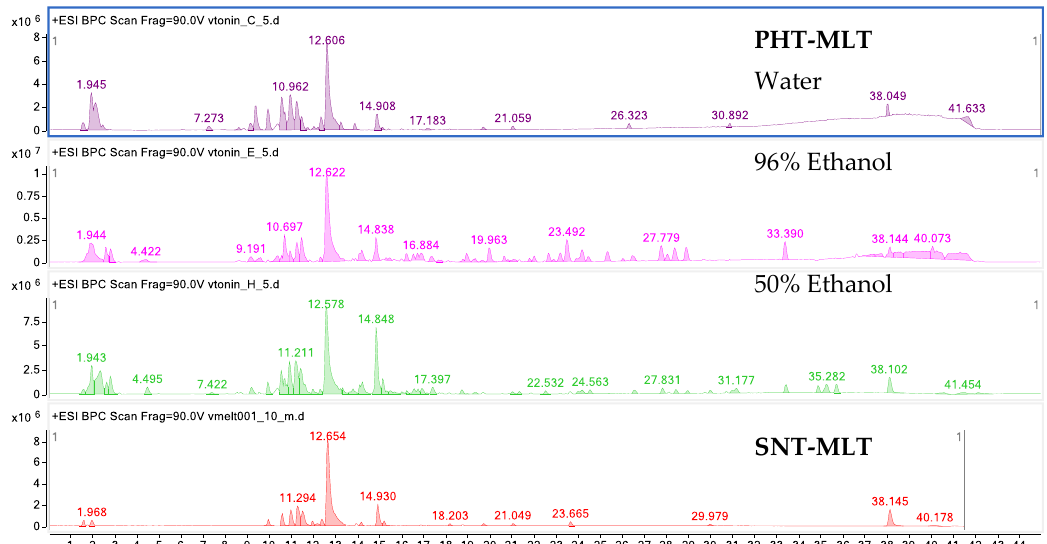
Figure 1. Mass chromatograms from the obtained PHT-MLT extracts and SNT-MLT (in the bottom) recorded in the positive ionization mode.